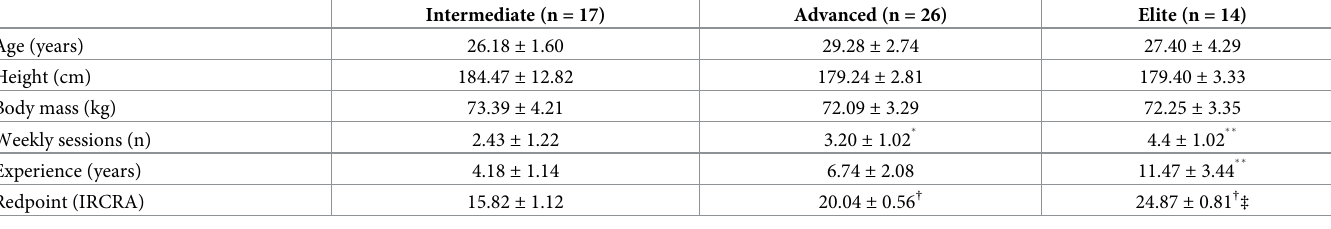
Table 1. Anthropometric data, climbing experience, weekly number of climbing sessions, and average onsight grade of the participants given according to the numerical grading scale (1–32) suggested by the International Rock Climbing Research Association (IRCRA). The values are presented as means ( ± standard